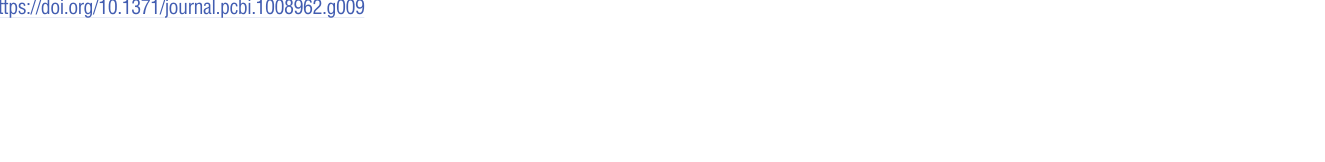
PLOS Computational Biology | https://doi.org/10.1371/journal.pcbi.1008962 May 6, 2021 18 /